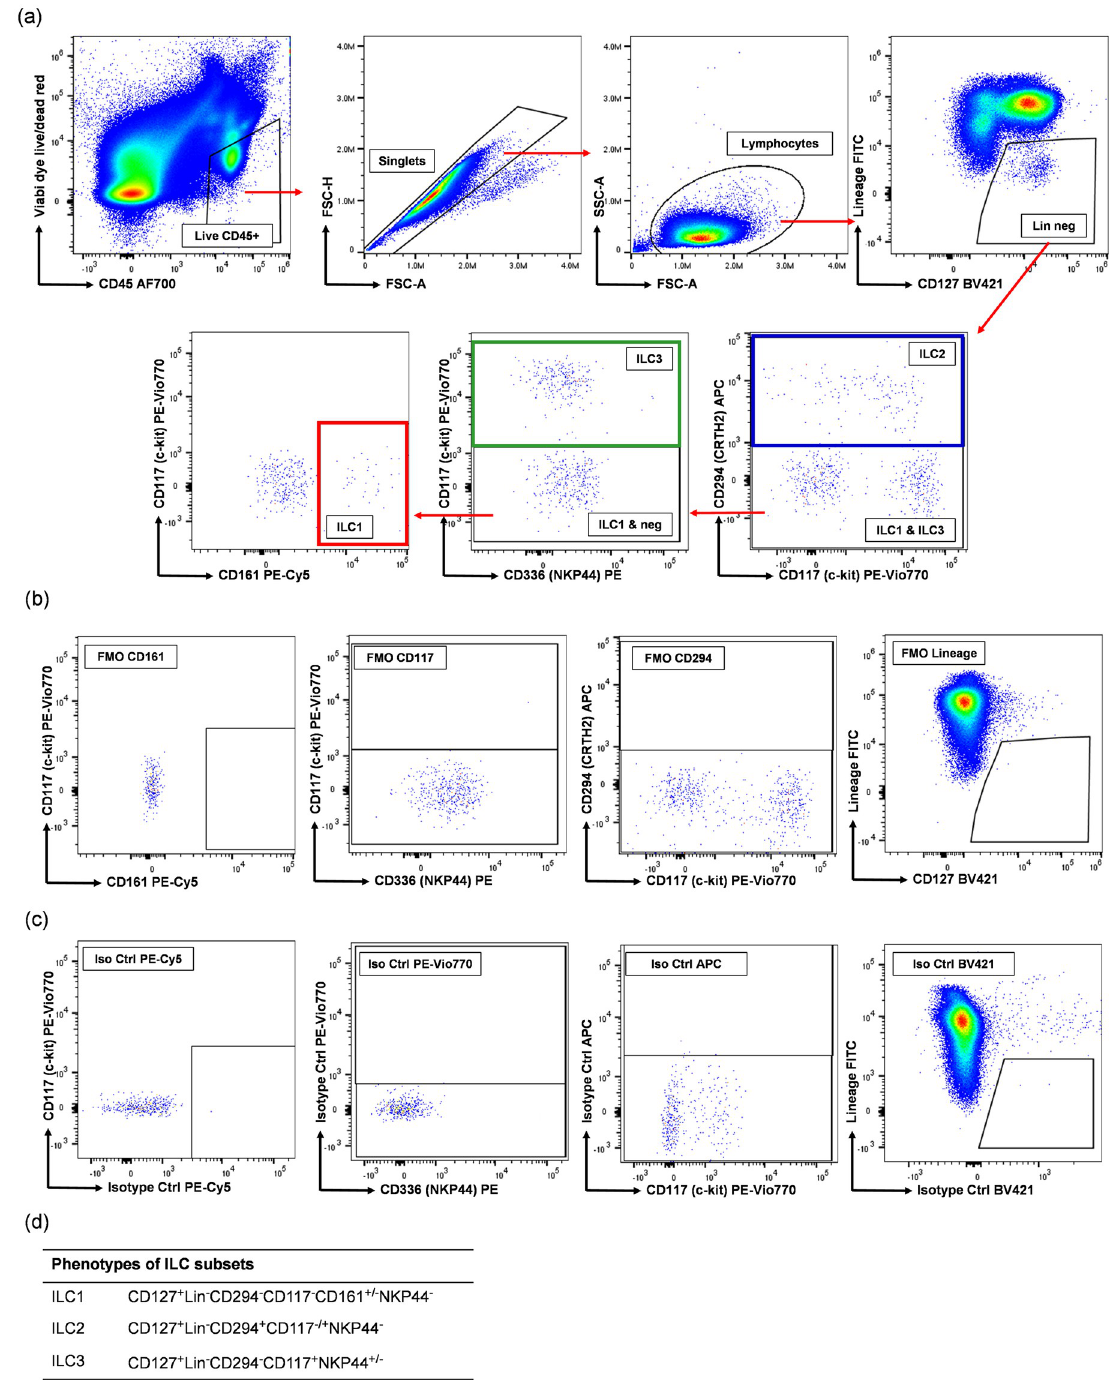
Fig 1. Flow cytometric gating strategy for ILC1, ILC2 and ILC3. ILC were defined as live CD45 + cells, which were then gated on forward scatter height (FSC-H) vs FSC area (FSC-A) to exclude doublets. Singlets were than gated on side scatter area (SSC-A) vs FSC-A to select lymphocytes. ILC were then defined as CD127 + lineage-negative, with the lineage ‘cocktail’ consisting of antibodies specific for CD1a, CD3, CD11c, CD14, CD19, CD34, CD94, CD123, CD303, FC ε RI, TCR αβ and TCR γδ . ILC1 were then defined as CD117 - CD161 + , ILC2 as CD294 + and ILC3 as CD117 + NKP44 +/- (a). Cell populations were identified based on Fluorescence Minus One (FMO) controls (b) and isotype controls (c). Phenotypes of ILC subsets are described in table in panel (d).